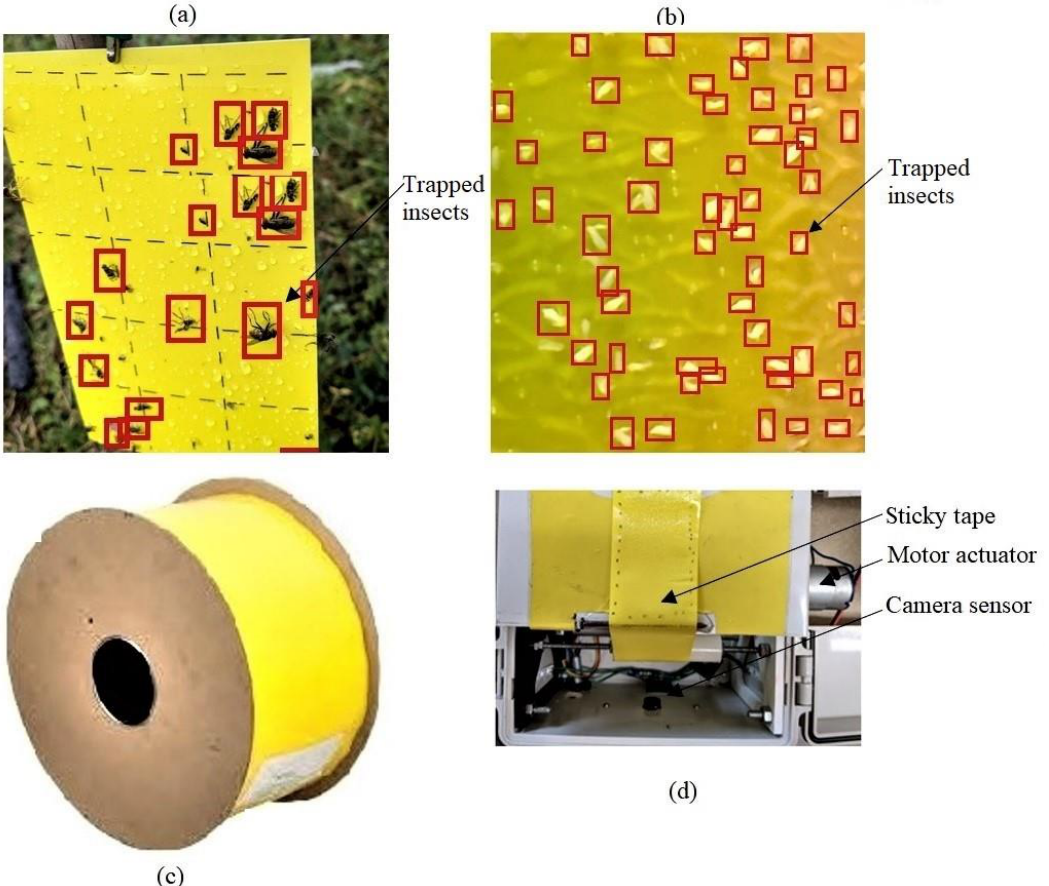
Figure 4. Photographing insect pests on the stationery and automated rotating sticky trap. ( a ) Pest detected on a non-automatic rotating sticky trap card, ( b ) Insects detected on the rotating sticky roller, ( c ) Sticky trap roll for an automatic rotating sticky trap, ( d ) Sticky trap under the automated rotating system (adapted from [32,50] .